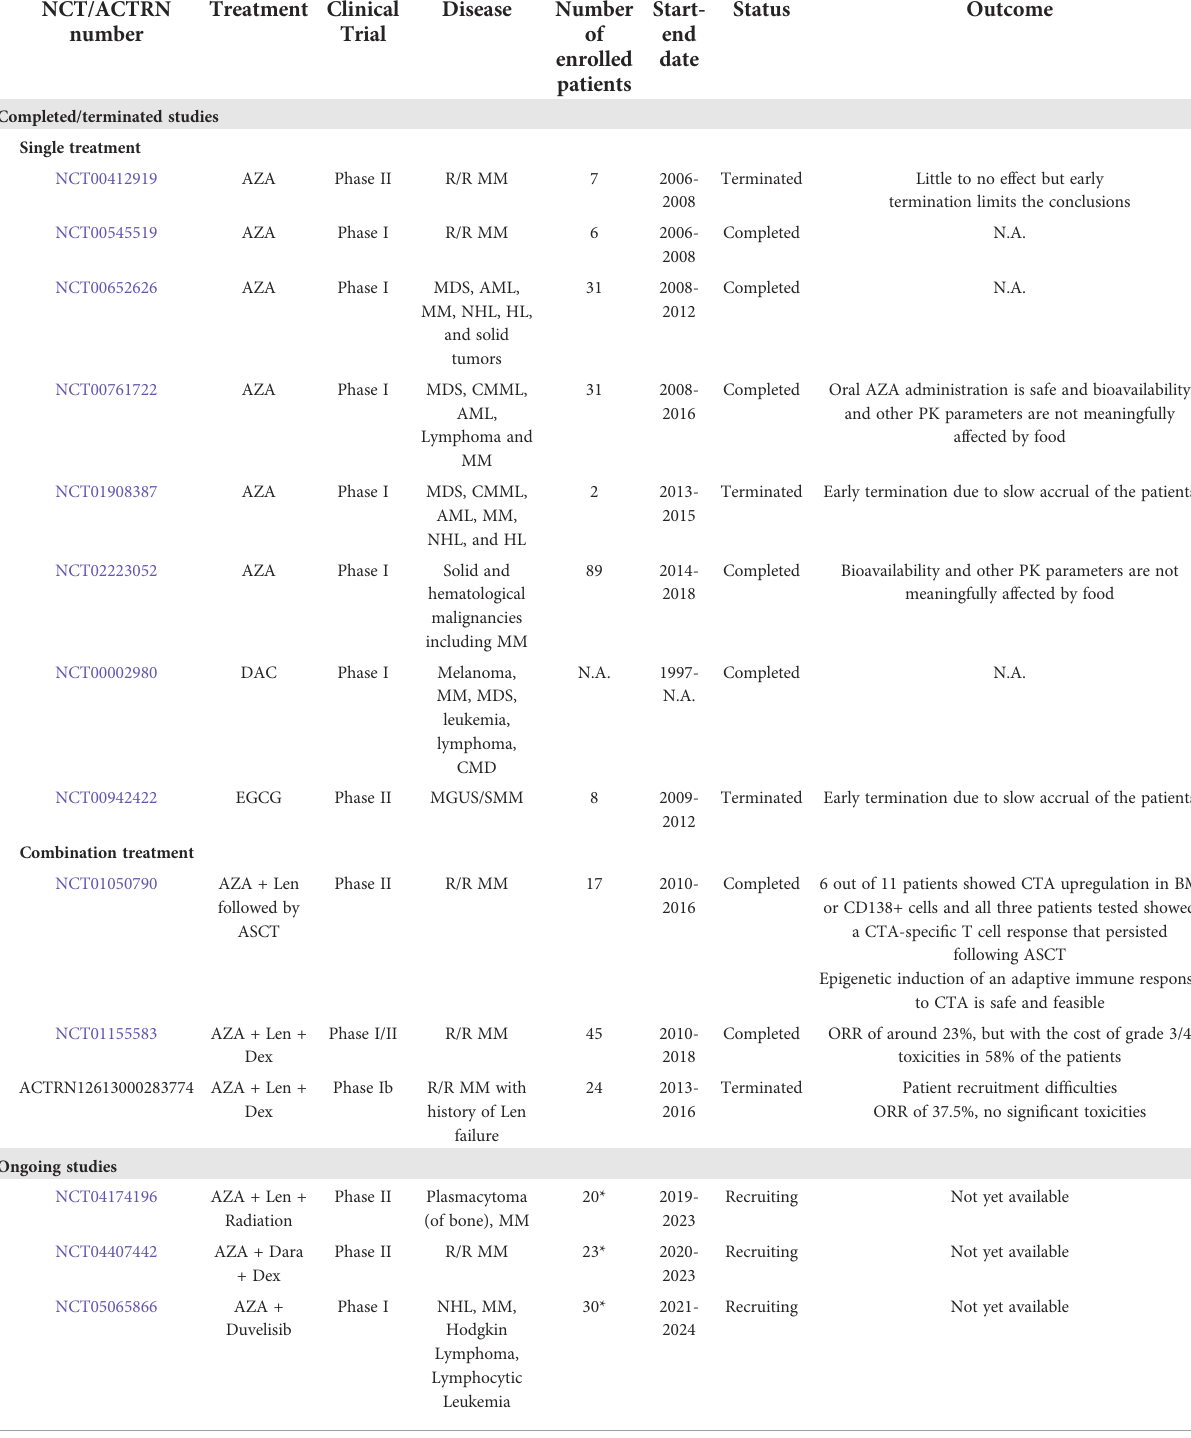
TABLE 5 Completed/terminated and ongoing clinical trials in MM testing